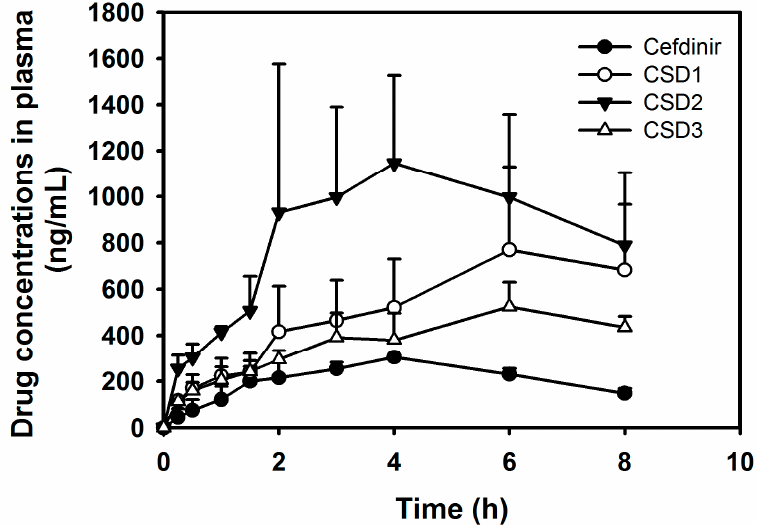
Figure 9. Plasma concentration–time profiles of cefdinir after oral administration of cefdinir and CSDs formulations (CSD1, CSD2, and CSD3) at a dose of 2 mg/kg in rats. Each point represents the mean ± standard error ( n = 3–4).